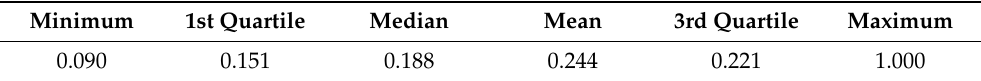
Table 2. Summary of the calculated OBP sequence